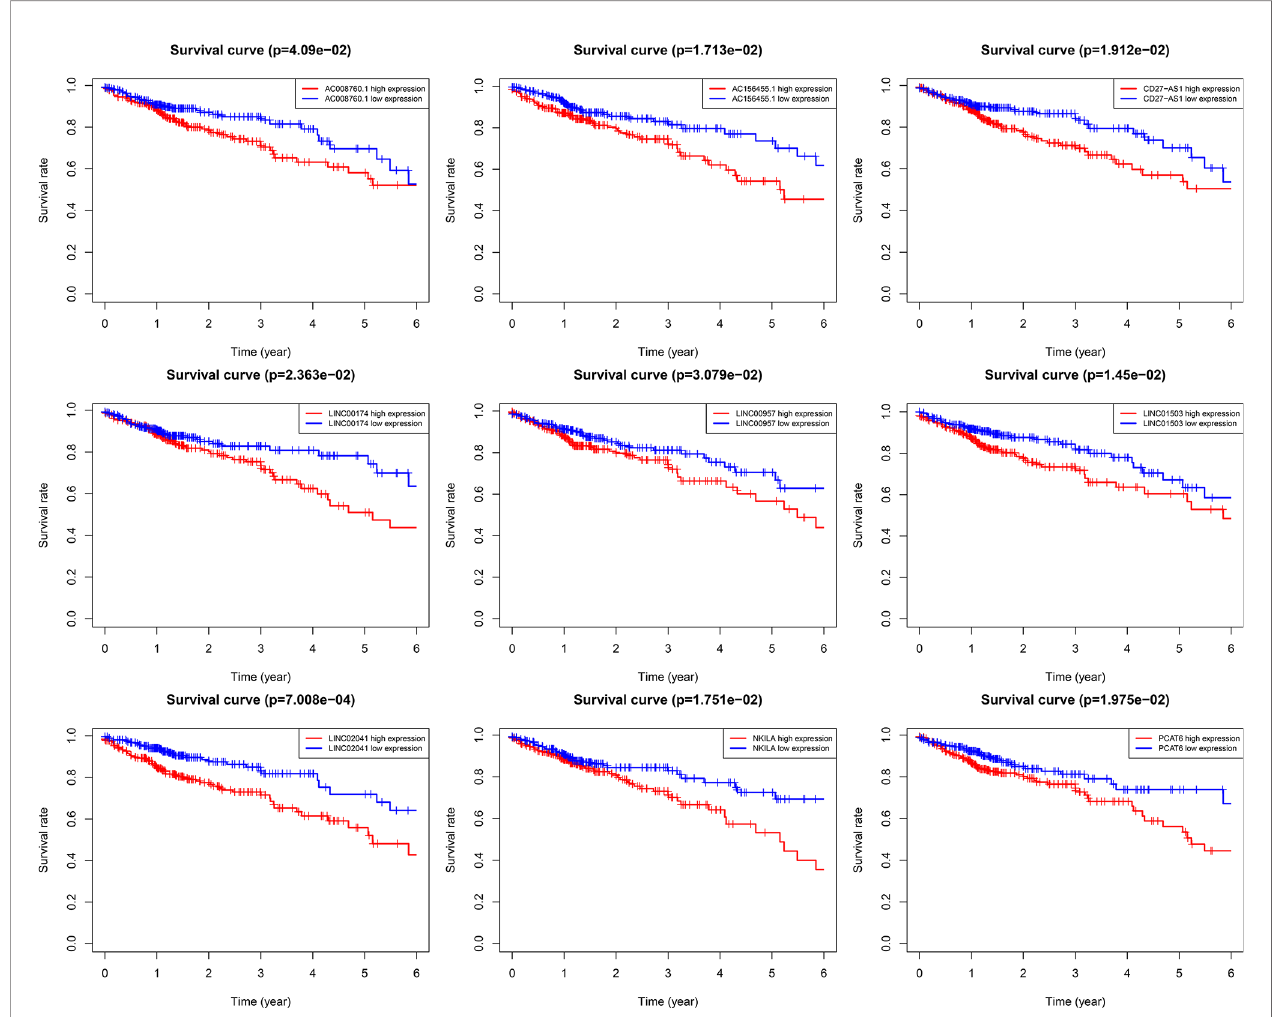
FIGURE 3 | Kaplan – Meier 5-year overall survival (OS) curves for two groups divided by high and low expression level of ARlnRNAs. The red curves correspond to patients with high expression level of ARlnRNAs, while the blue curves correspond to patients with low expression level of